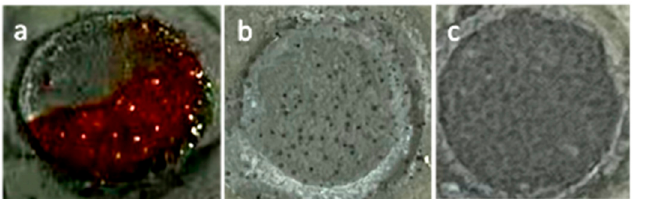
Figure 11. Visual observations of the different coating samples exposed to 3.5 wt.% NaCl solution for 300 h of immersion: ( a ) neat EP/Zn, ( b ) GO/EP/Zn, and ( c ) PGO/EP/Zn samples. The diameter of the circle in the image is 1.1 cm.